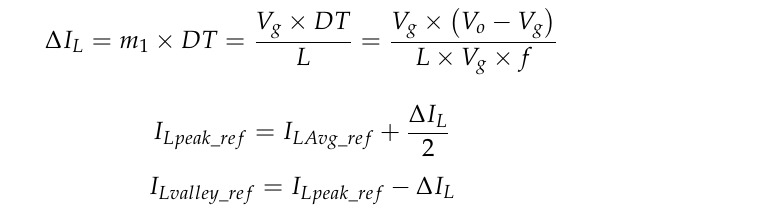
Figure 14. Proposed hybrid current mode control block diagram.